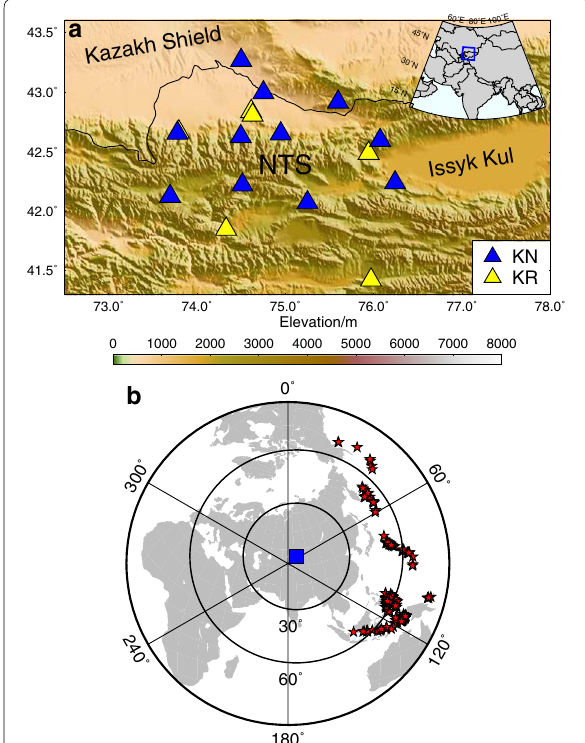
Fig. 2 a Map of the northern Tien Shan (NTS) region with the stations (triangles) from two networks KN (blue) and KR (yellow). The inset shows the geographic location of the study region (blue square). b Distribution of teleseismic events (red stars) used in this study. The square represents the study